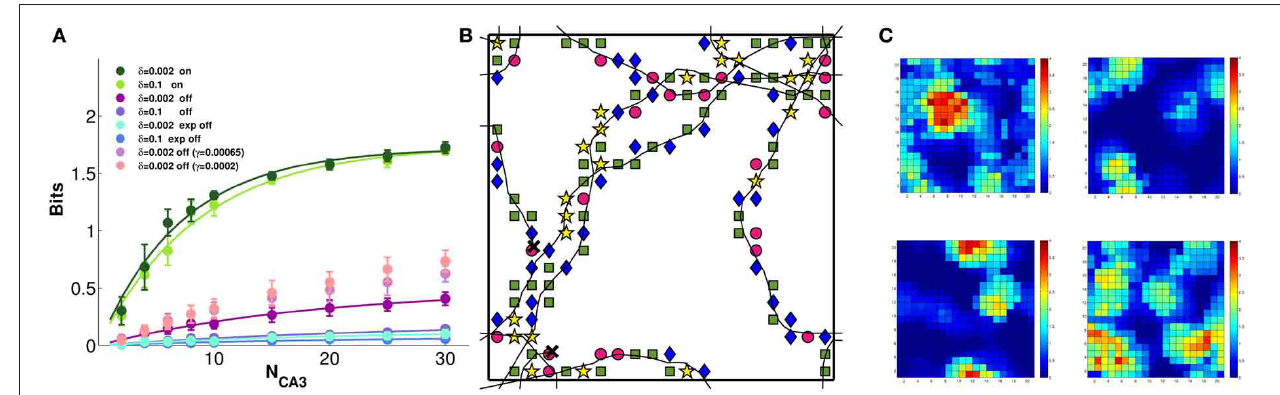
FIGURE 6 | Some context discrimination remains in memory, if self-organization is limited. The amount of information about which of 4 distinct environments is reflected in the DG inputs is extracted from subsamples of CA3 model units. (A) Decoding the activity driven by the inputs allows for good discrimination (the green curves, which are fitted to the data points as before), irrespective of noise. Turning the inputs off greatly reduces the context information retained in all cases, but more information remains when the network is allowed to self-organize, and noise is very low (purple curve). In contrast, pre-wired connectivity appears not to be suitable for context discrimination (light and dark blue curves).